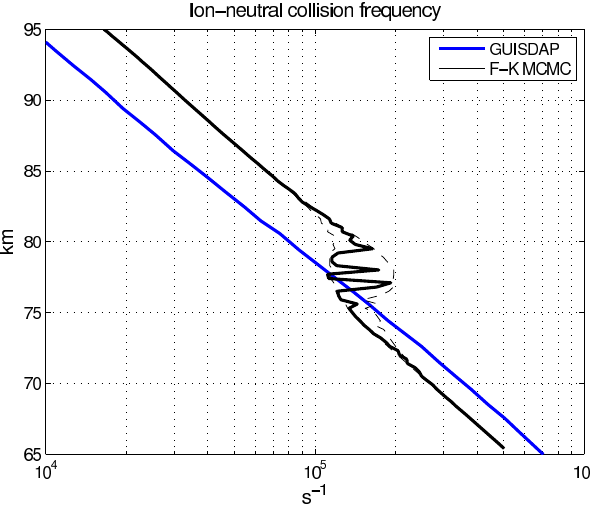
Fig. 7. Comparison of the fixed ion-neutral collision frequency profile of GUISDAP, calculated from MSIS N 2 , O 2 and O, and the Fukuyama-Kofman MCMC fit. The F-K fit reproduces the mesopause well whereas the exponential GUISDAP profile, likely differing from the real one, may cause misinterpretation of the elec- tron